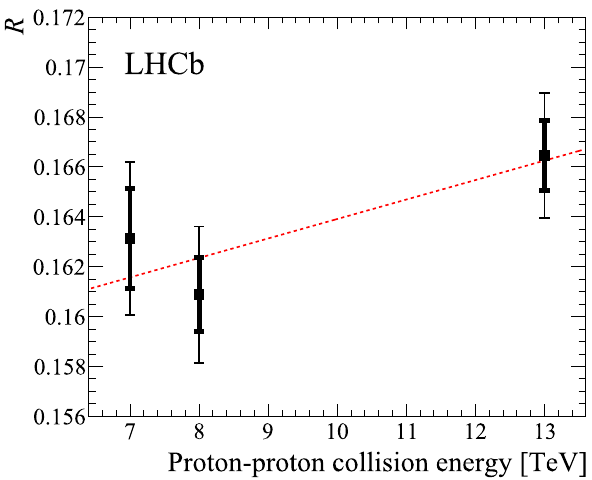
Fig. 5 Visualisation of the pp collision energy dependence of the efficiency-corrected yield ratio of B 0 s → D + s π − and B 0 → D − π + decays, which scales with f s / f d . The inner error bars indicate the sta- tistical uncertainty only, whereas the outer indicate the uncorrelated, including statistical, uncertainties. The correlated systematic uncer- taintyisnotshown. Thereddottedlinerepresentsalinearfitthrough the three values of R with uncorrelated, including statistical, uncertainties 8